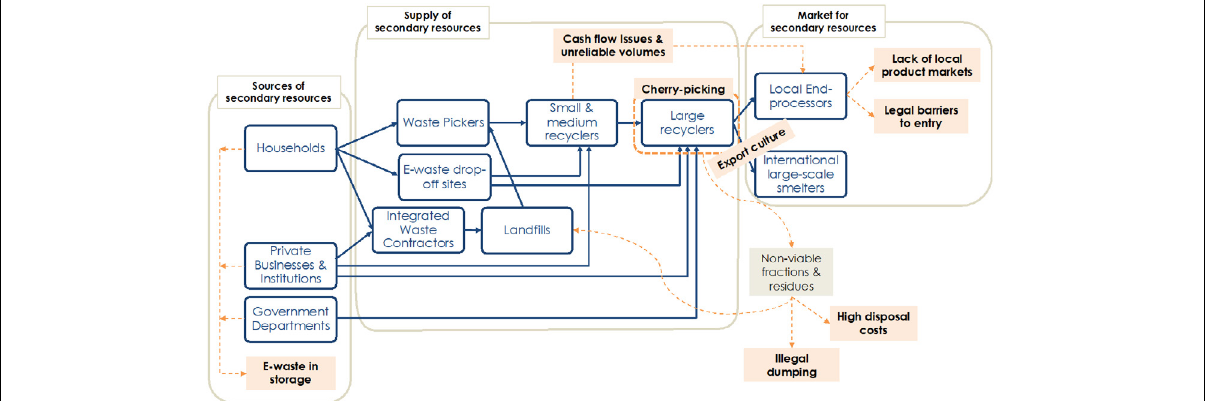
Figure 3: Barriers to local end-processing of e-waste in South Africa.